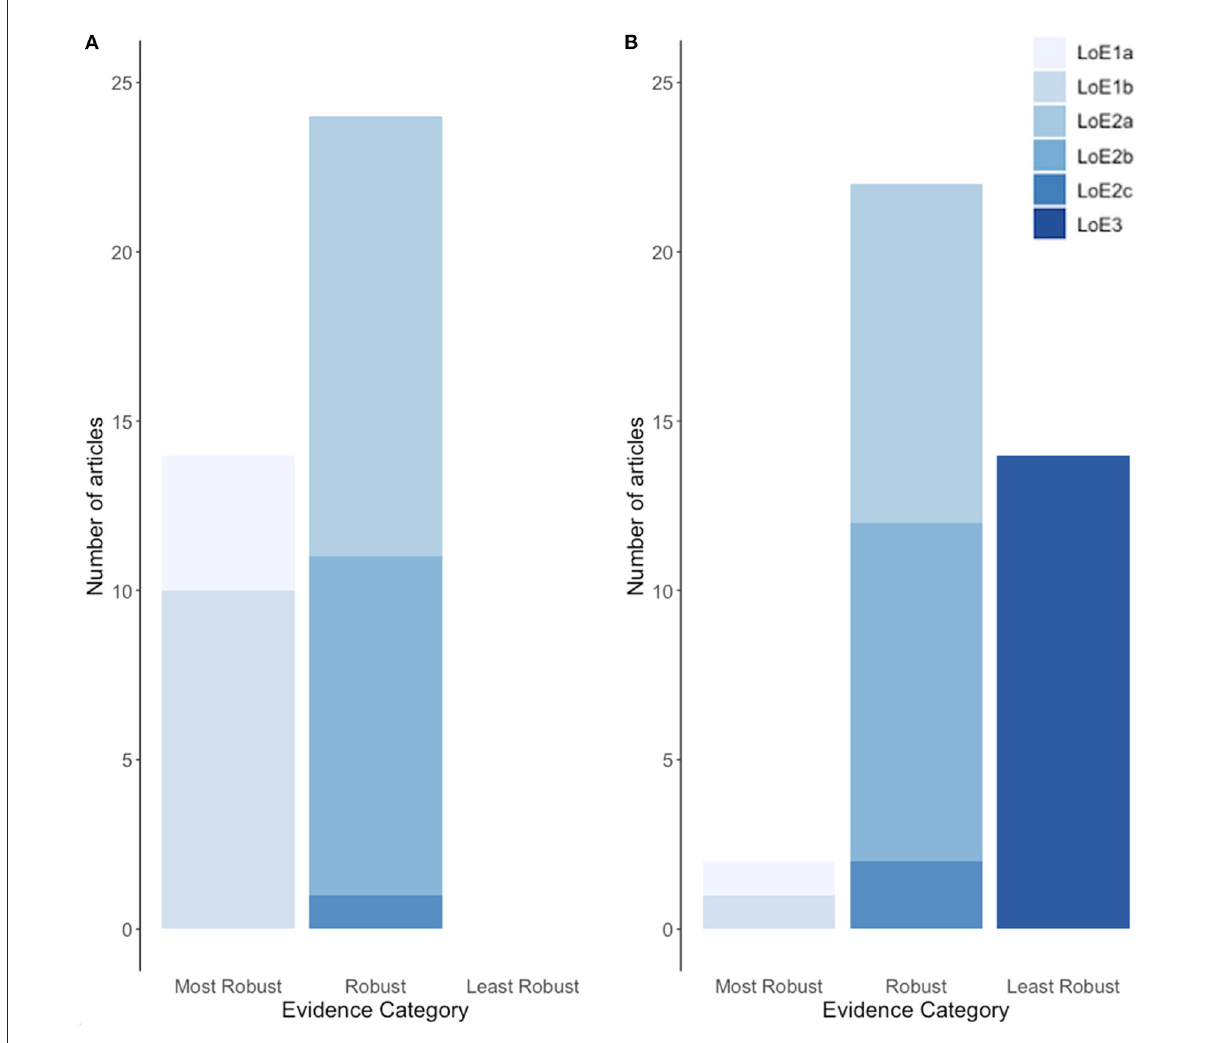
FIGURE5 Evidence assessment scores for study design (A) and adjusted scores based on critical appraisal of study quality (B)